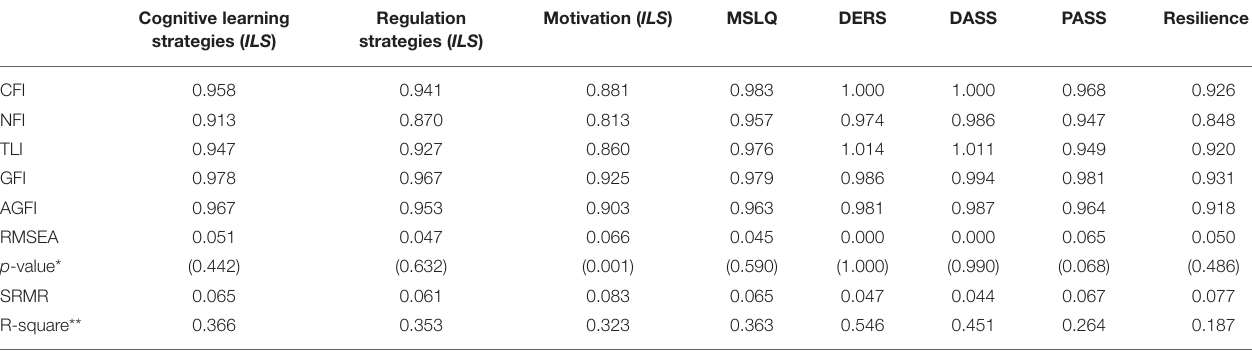
TABLE 1 | The CFA on the instruments used in our study. Cognitive learning strategies ( ILS )